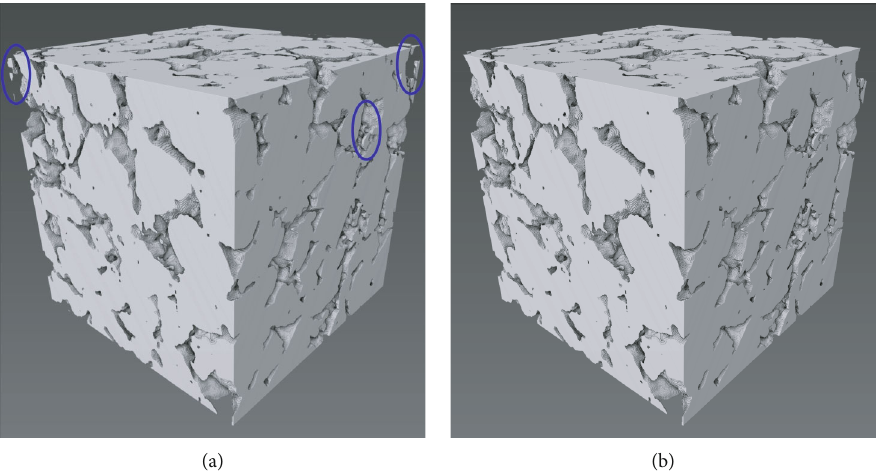
Figure 9: (a) Digital core a and (b) corrected digital core a.